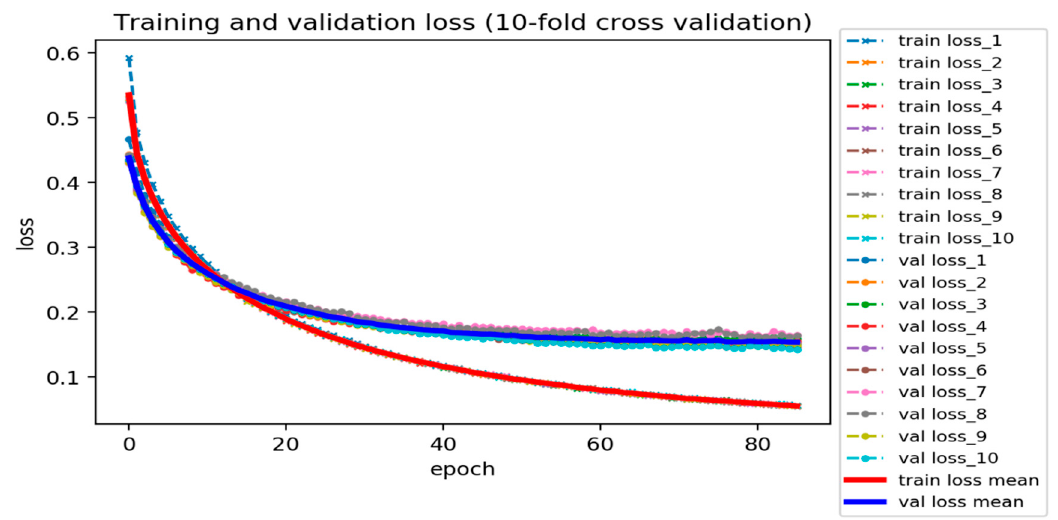
Figure 5. Training and validation loss of DNN-based DTI model (10-fold cross-validation).